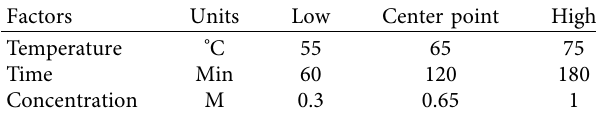
Table 1: Actual levels of design factors